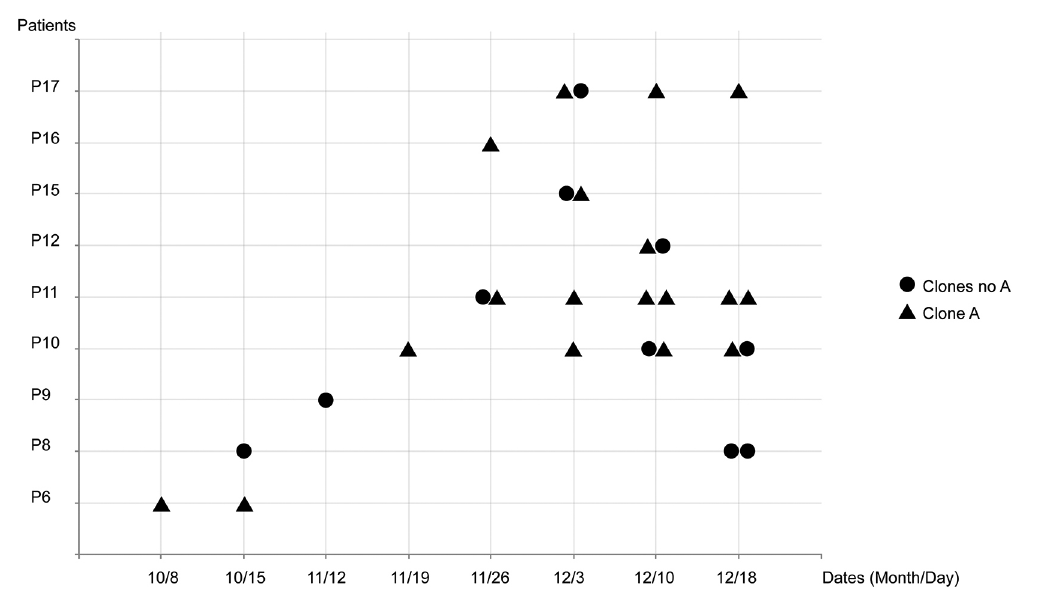
FIGURE 1 - Temporal analysis of the Pseudomonas aeruginosa found in the patient´s